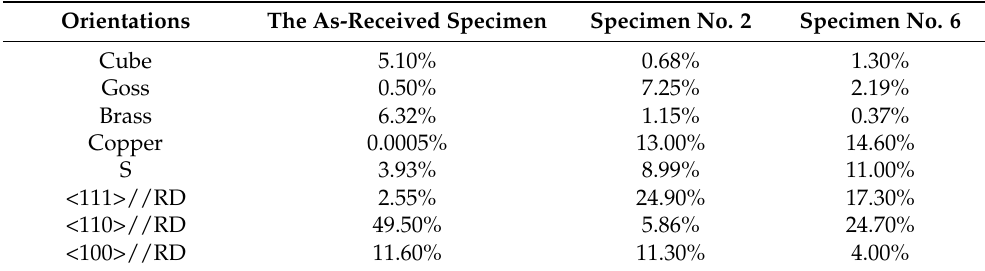
Figure 12. ODF maps of the as-received specimen ( a , d , g ), specimen No. 2 ( b , e , h ), and specimen No. 6 ( c , f , i ) at φ 2 = 45°, 65° and 90°. Table 3. Volume fractions of the typical microtextures of the as-received specimen, specimen No. 2, and specimen No. 6.